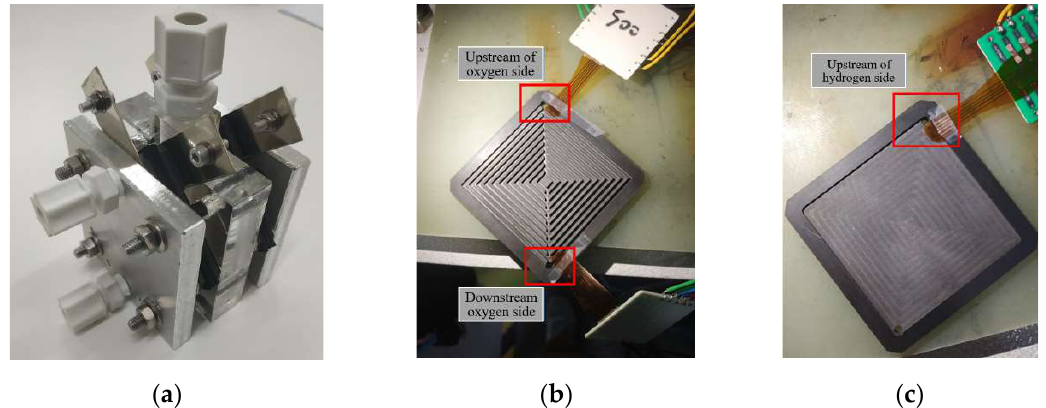
Figure 11. ( a ) Entity of a proton battery stack; ( b ) the position of the flexible six-in-one microsensor embedded in the oxygen side; ( c ) the position of the flexible six-in-one microsensor embedded in the hydrogen side.